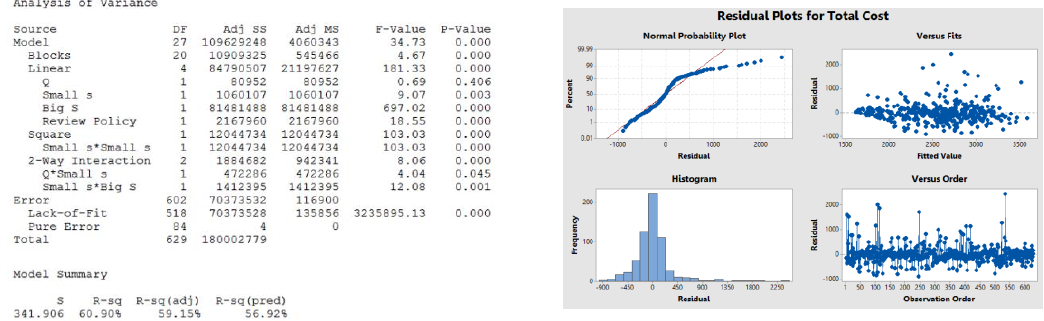
Figure 15. Analysis of variance and residual plot of Box–Behnken design.